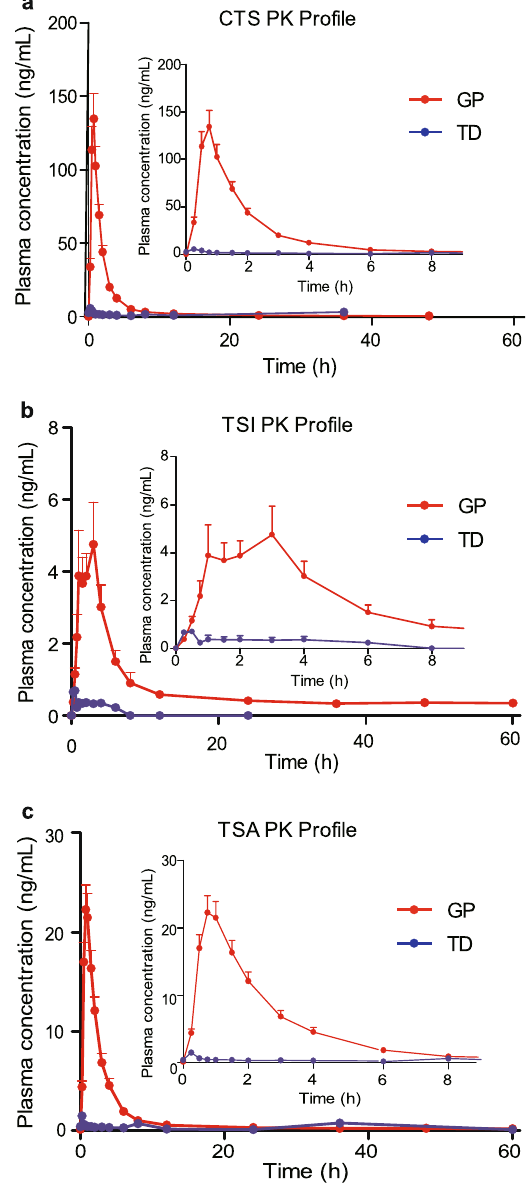
Figure 3. Arithmetic mean ( ± standard error) plasma concentration–time profiles of cryptotanshinone ( a ), tanshinone I ( b ) and tanshinone IIA ( c ) after administration of Salvia miltiorrhiza granule powder (GP) and traditional decoction